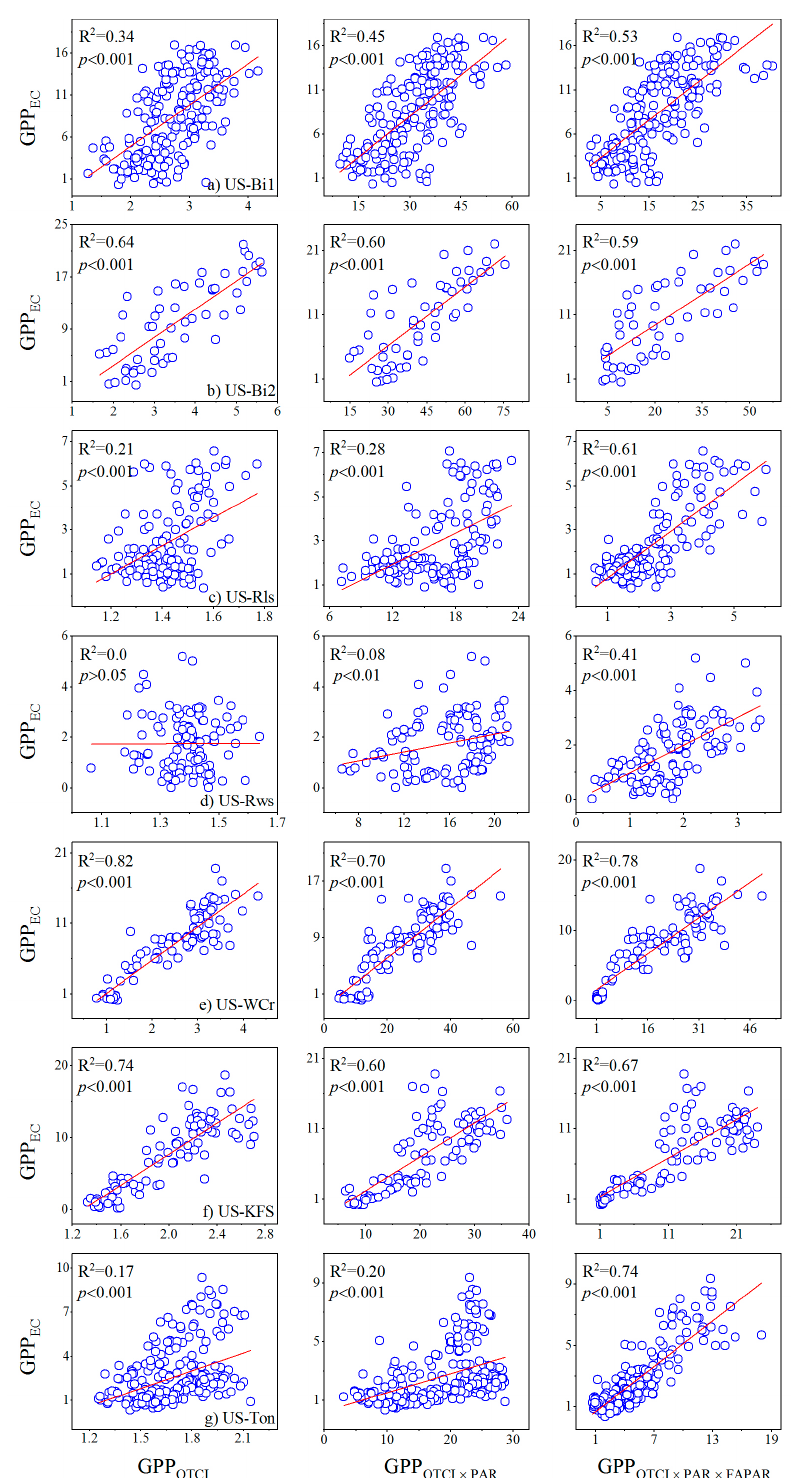
Figure 8. Scatterplots between GPP EC and GPP OTCI for all sites in 2017 and 2018. The left column represents model 1: GPP = ƒ(OTCI), the middle column represents model 2: GPP = ƒ(OTCI × PAR), and the right column represents model 3: GPP = ƒ (OTCI × PAR × FAPAR). ( a – g ) represent the sites the same as Figure 2.